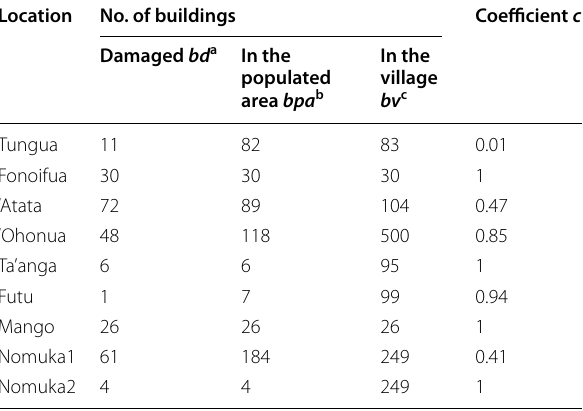
Table 4 Comparison of damages to buildings between UNOSAT (2022) data and results from this study Information provided by UNOSAT (2022)